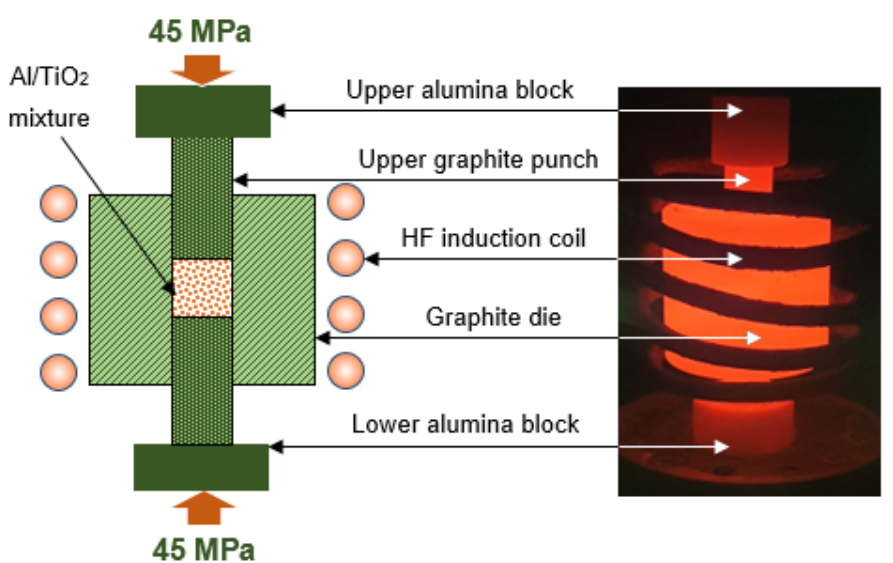
Figure 2. Graphite die setup used for sintering/consolidation process.